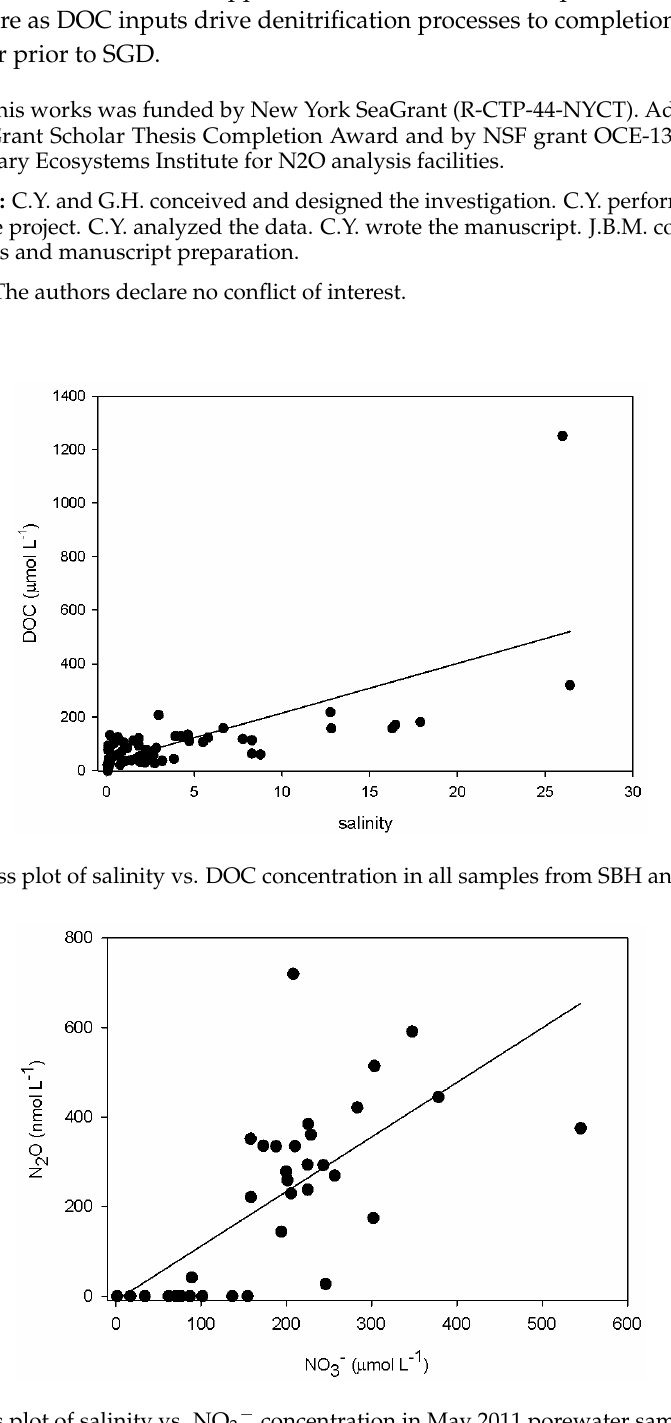
Figure A2. Cross plot of salinity vs. NO 3− concentration in May 2011 porewater samples from SBH.